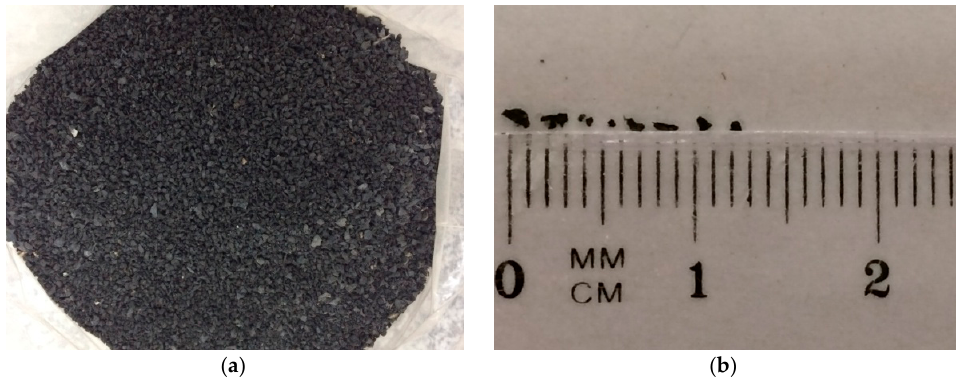
Figure 2. Rubber chips used in this study with a size of 0.06–0.4 mm. ( a ) Rubber chips; ( b ) particle size.